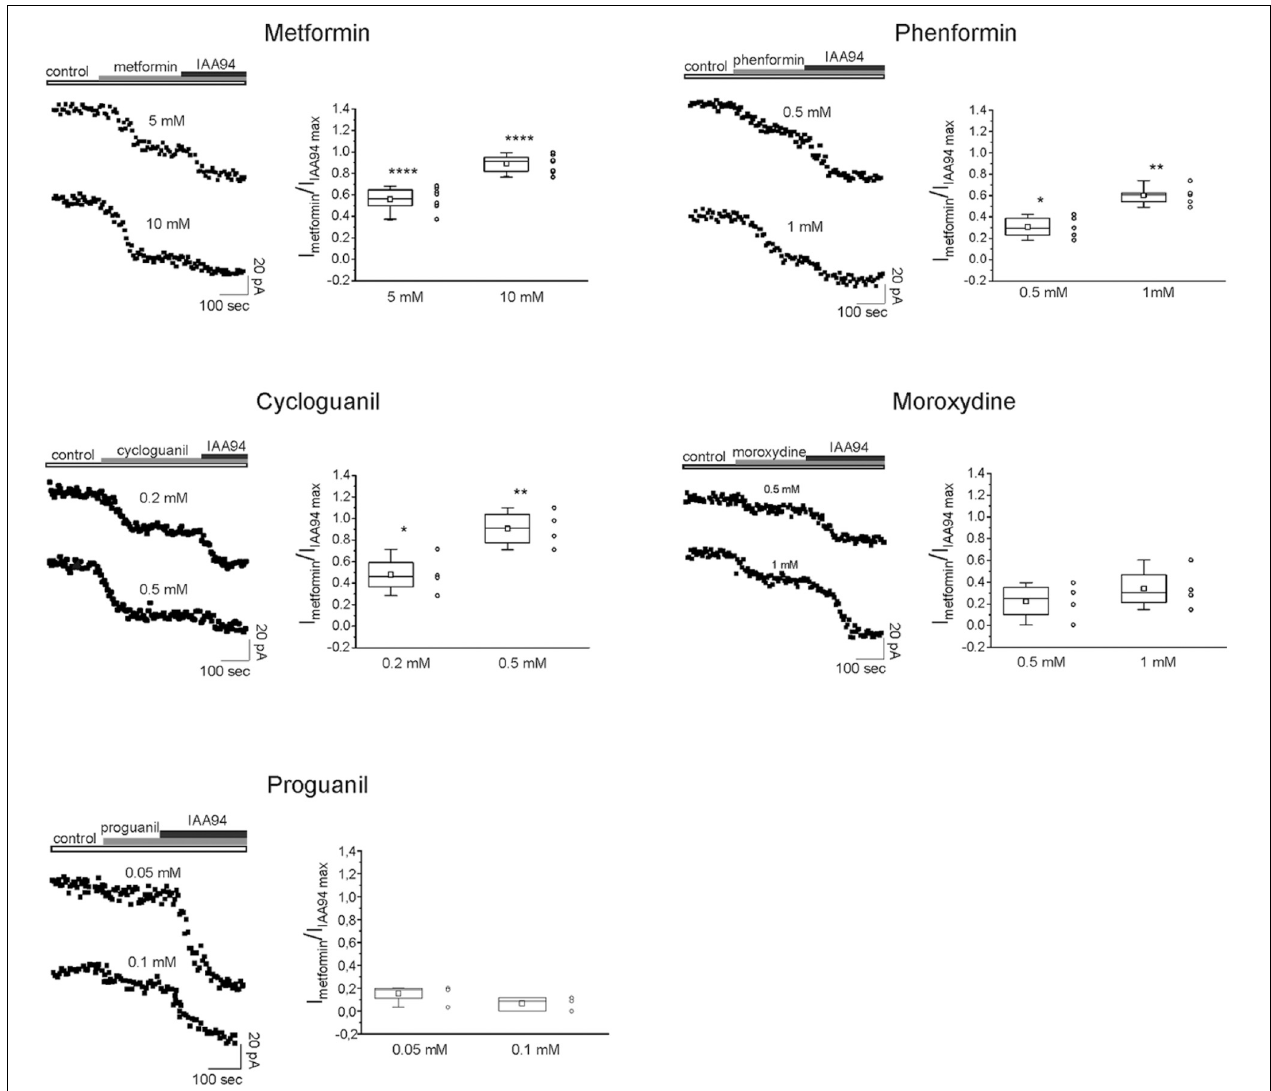
FIGURE 8 | CLIC1 associated membrane current inhibition by biguanide compounds. Membrane current from GBM2 has been elicited by a 100 mV voltage step, from –40 to +60 mV, 800 ms in duration. Stimulus has been delivered every 10 s to generate a current amplitude time course. CLIC1 current inhibition is calculated as ratio of the effect induced by each compound and the inhibition observed after IAA94 (100 µ M) treatment that represents the residual CLIC1 activity. For each compound are shown experimental data at two different concentrations reported on the top of each current time course (left) . The (right) depict box chart plots showing the average inhibition of CLIC1 current, calculated as ratio between the compound and IAA94 sensitive currents. Number of cells used for the statistics range from 4 to 8 for each compound concentration (empty circles next to box charts). Unpaired t -test: ∗ p < 0.05, ∗∗ p < 0.01, ∗∗∗∗ p < 0.0001 vs. CTR